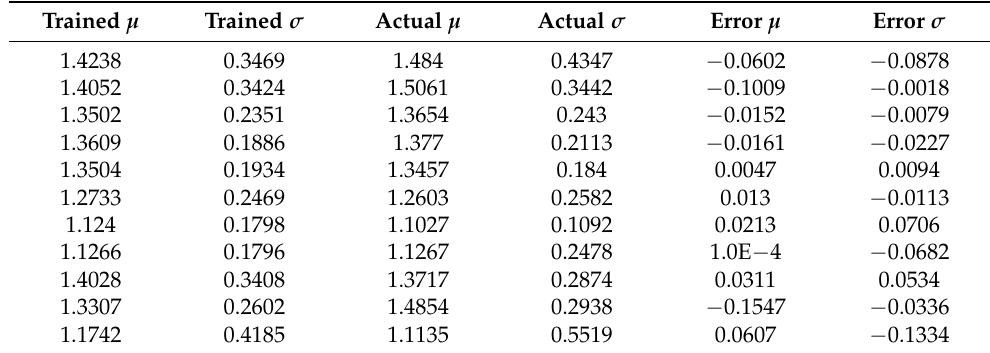
Table 5. Error estimation of the Lognormal PDF parameters.